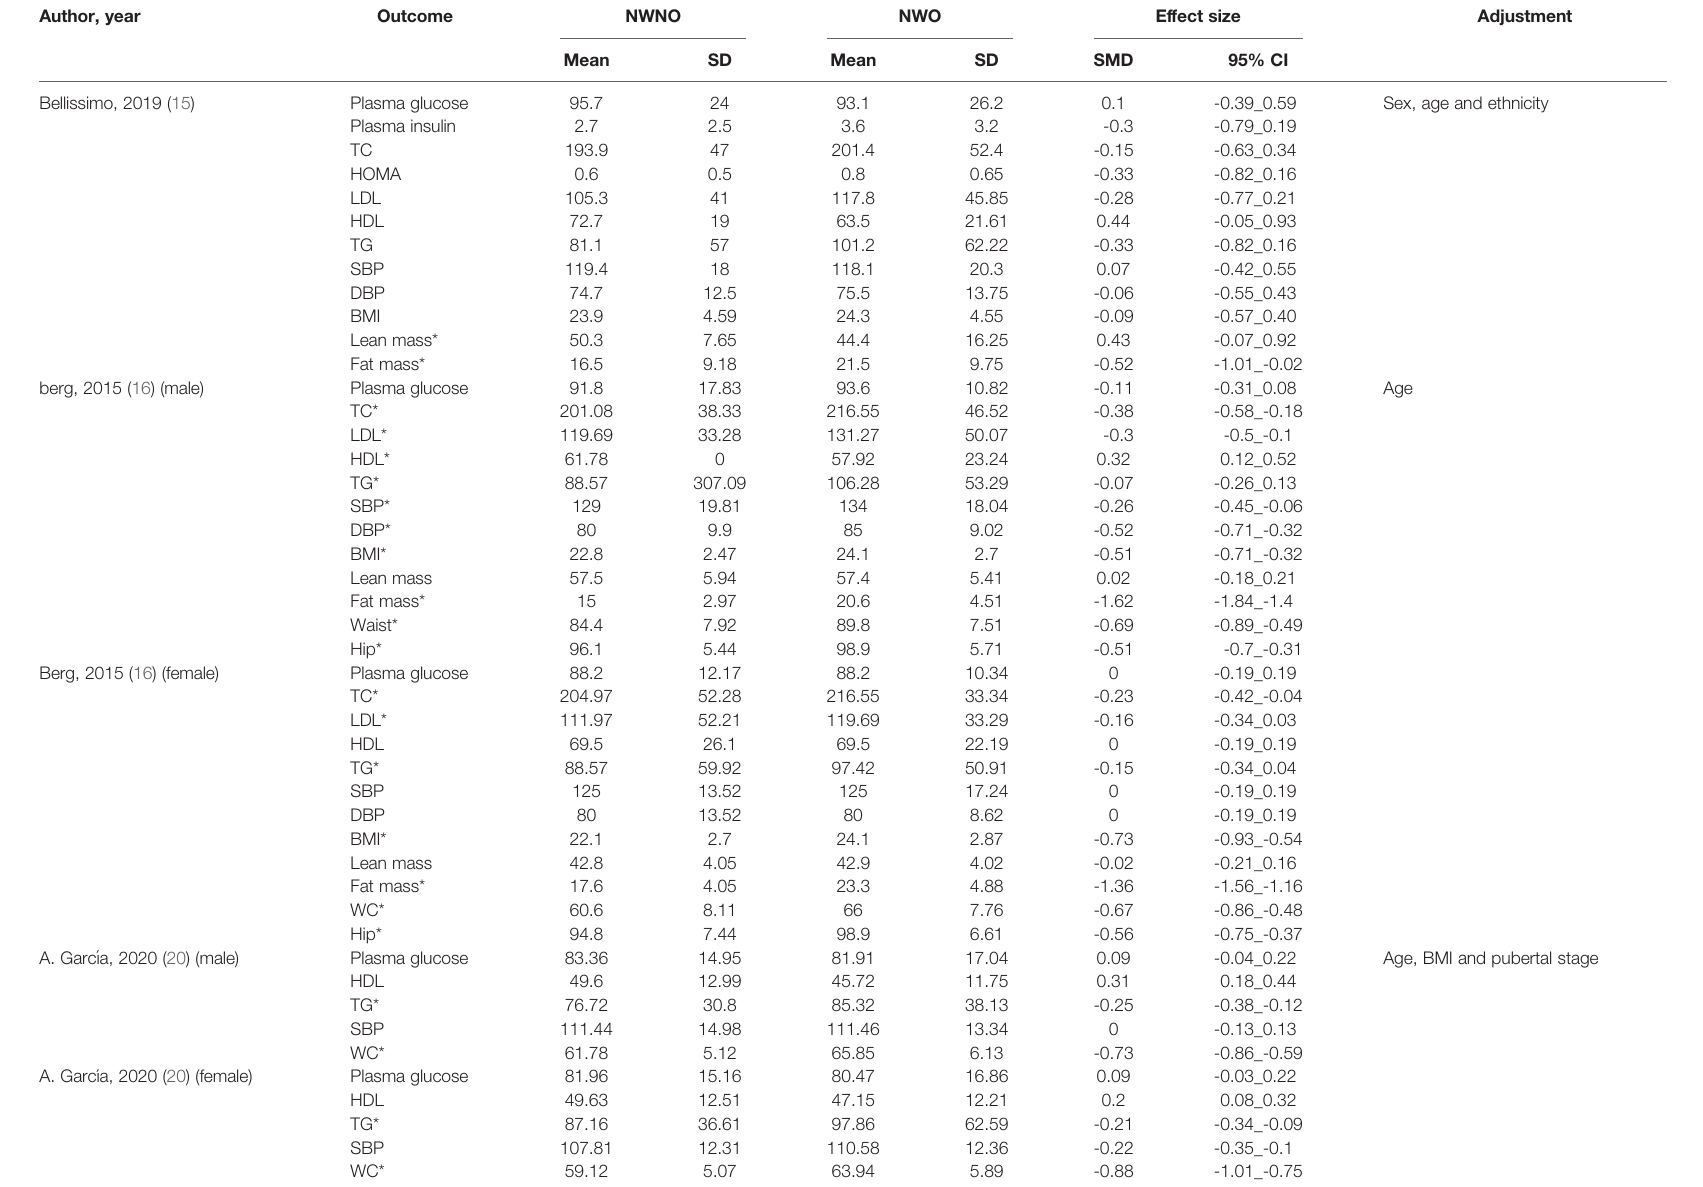
TABLE 2 | Association of NWO with mean of CMRFs in included studies. Author,